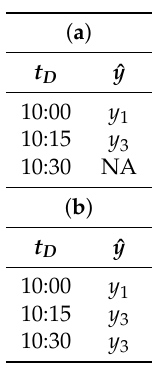
Table 4. Result of forward join. ( a ) After applying the join. ( b ) After filling NA